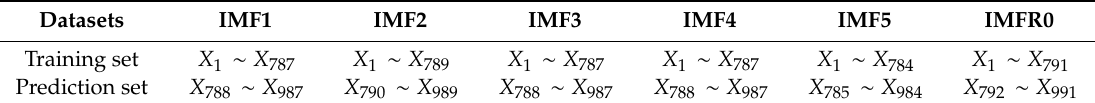
Table 3. Phase space reconstruction parameters for each component. IMF1